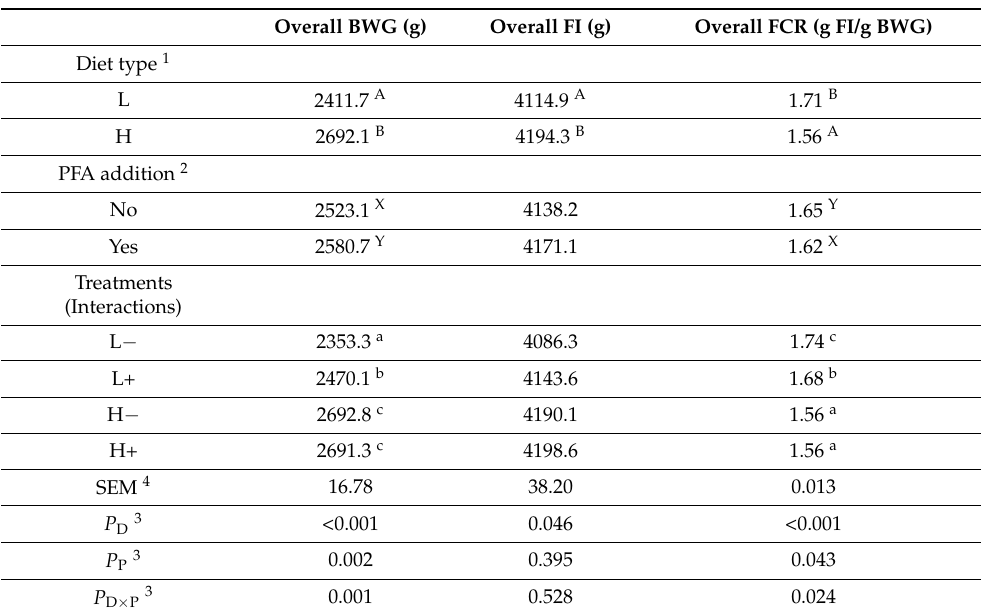
Table 2. Overall broiler growth performance